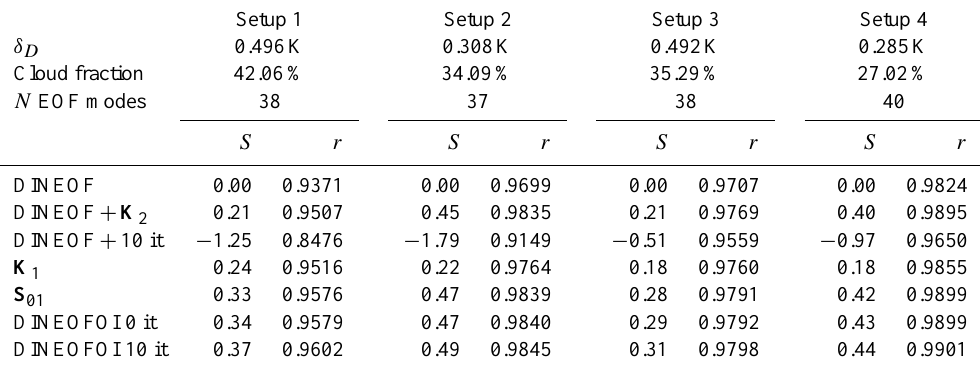
Table 1. Skill scores and correlation coefficients for the four SEVIRI setups and the different methods. DINEOF stands for the direct use of standard DINEOF results. DINEOF + K 2 uses the simple approach of adding a local optimal interpolation of residuals. DINEOF + 10 it stands for the method in which we start from DINEOF results and then apply the iterative version using K 1 based on the EOFs. Version K 1 uses only the EOF-based covariances, S 01 stands for the simple approach when we add the local optimal interpolation of residuals to the previous solution and finally the last two lines correspond with the full method with no iterations or 10 iterations (for inner iterations within K 1 combining space- and time-EOF-based interpolations, iterations are maintained in all